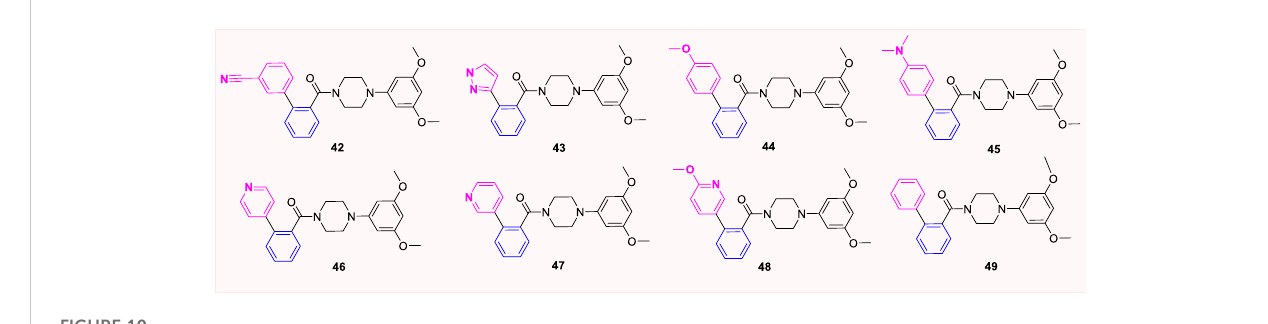
FIGURE 10 Structure of six-membered heterocyclic hybrid